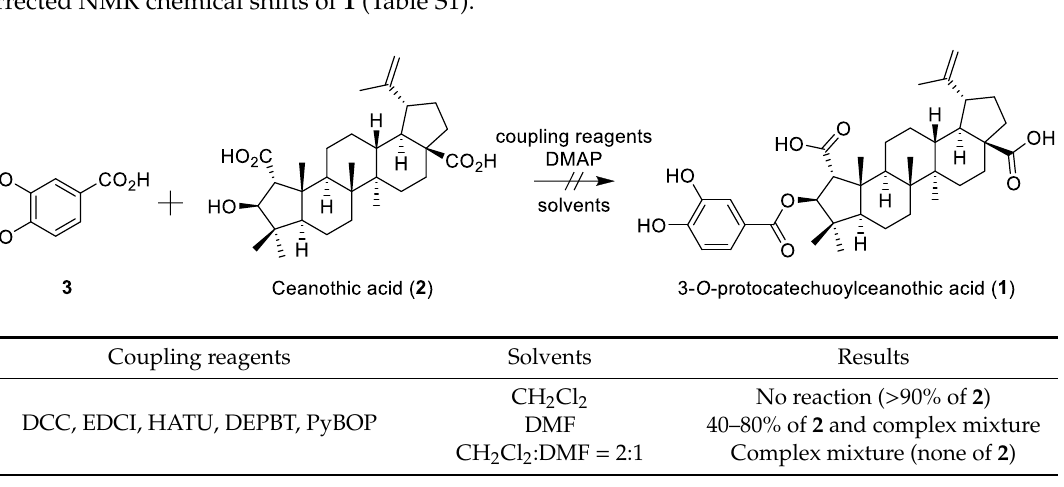
Molecules 2019 , 24 , x FOR PEER